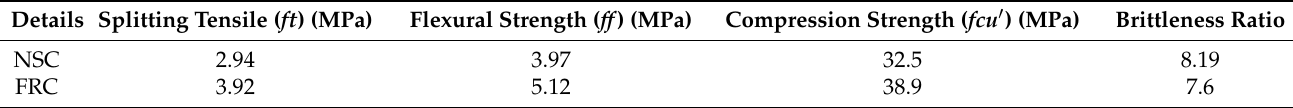
( c ) Figure 4. ( a ) All models, ( b , c ) details of reinforcement and details of V-shape. 2.4. Test Procedure Ten reinforced concrete specimens, separated into three groups, were made and tested under different loading conditions to study the influence of MSSFs reinforcement and inclination angle in FRC members. Both V-shaped and straight columns were tested